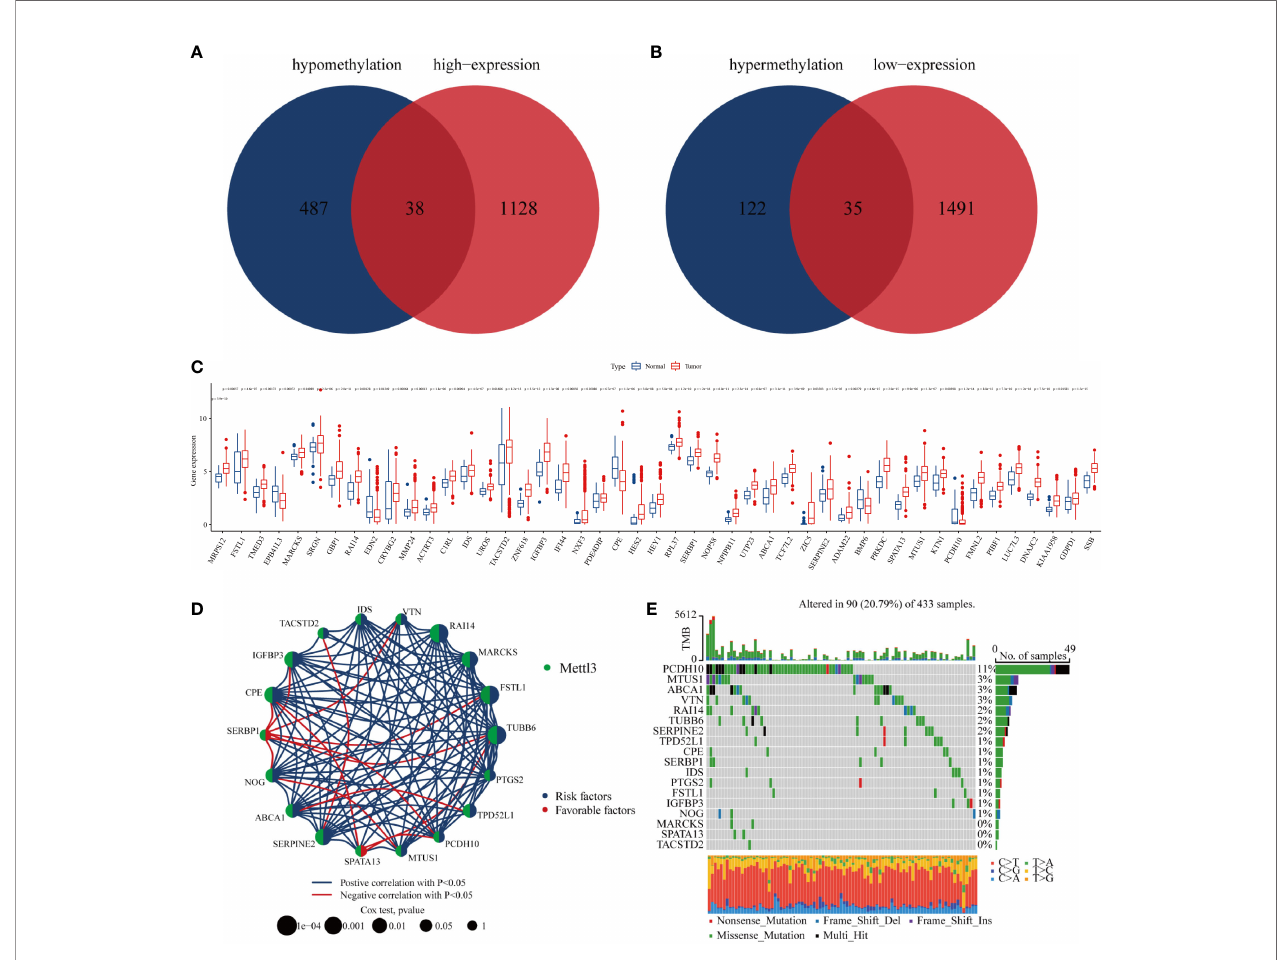
FIGURE 4 | Core genes regulated by METTL3. (A, B) Venn plot of combined transcriptome and epigenome sequencing of core genes; (C) differential expression of core genes in gastric cancer and normal gastric mucosal tissues; (D) core genes with independent prognostic value identi fi ed by Cox regression; (E) mutation rate of core genes with independent prognostic value in gastric cancer